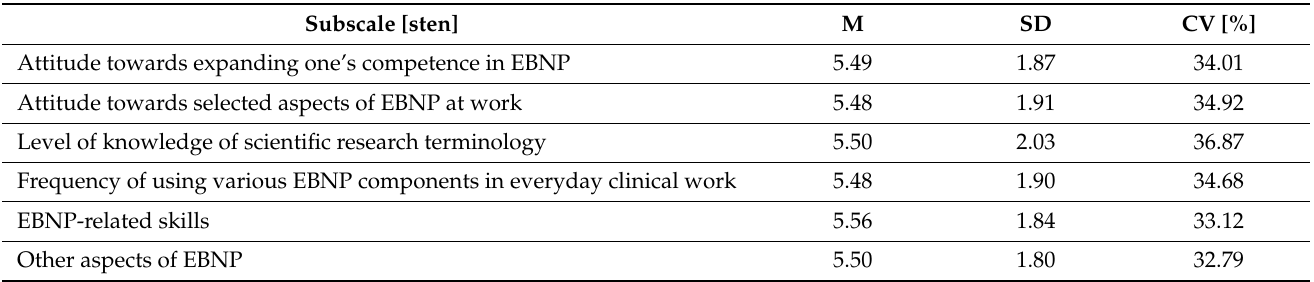
Table 2. Knowledge of, attitudes toward, and skills in EBNP according to the EBPPQ (sten scale) among the nurses under study.